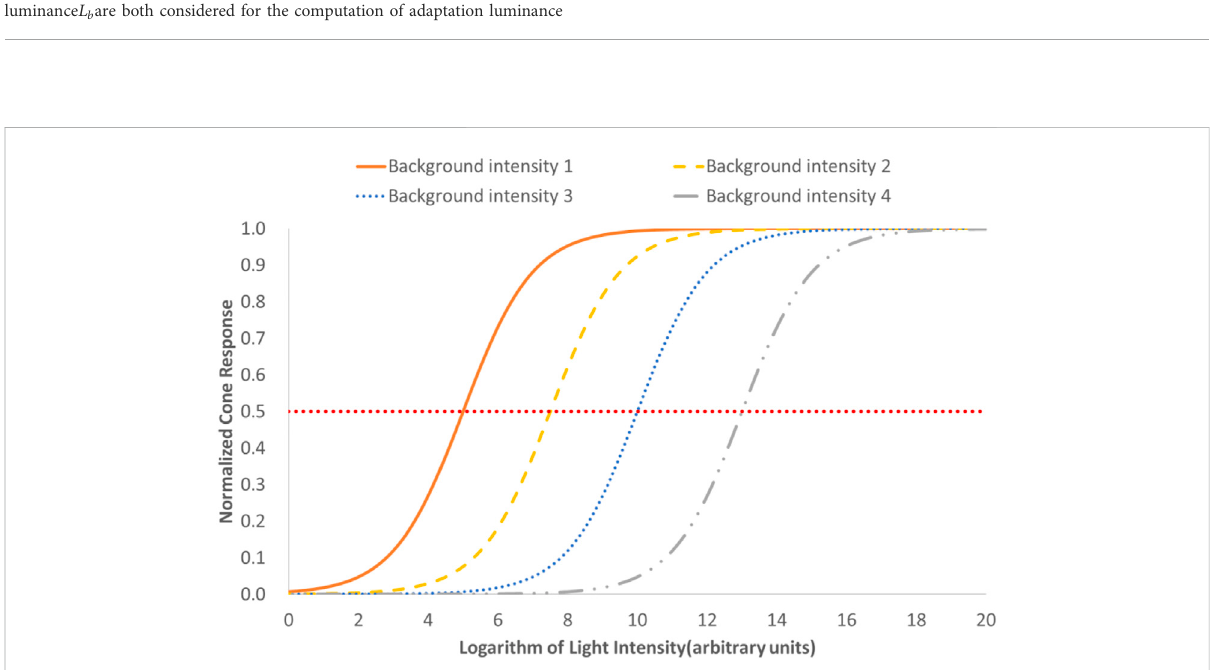
FIGURE 1 Diagrammatic drawing for the effect of cone ’ s light adaptation on its response to